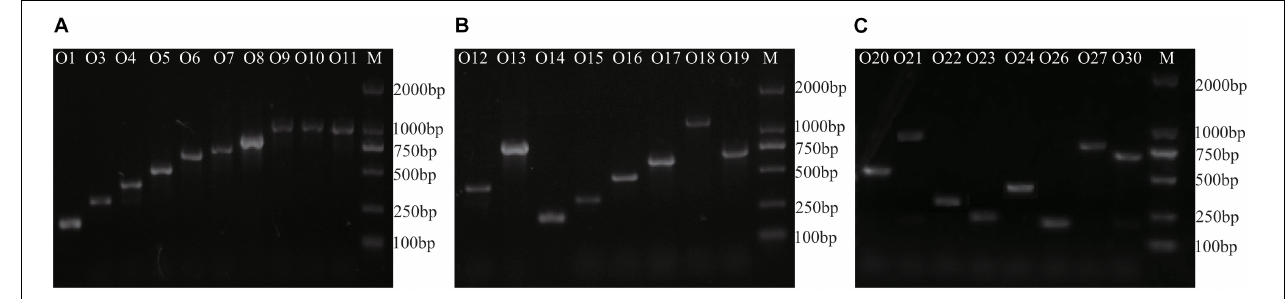
FIGURE 3 | Agarose gel electrophoresis of representative Multiplex PCR products from 26 E. cloacae reference strains. M, DL2000 DNA molecular standard. (A) products of group 1, (B) products of group 2, and (C) products of group